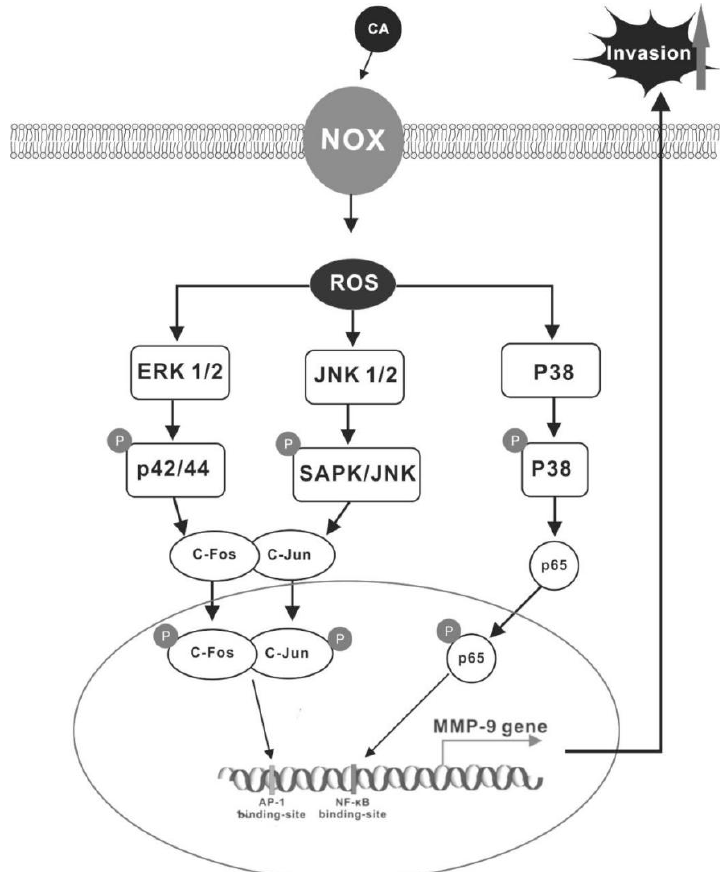
Figure 8. Scheme of the mechanism underlying CA-induced MMP-9 expression in colon cancer cells. CA stimulates NADPH oxidation, which in turn activates ROS-activated MAPK (ERK1/2, JNK, and p38 MAPK). ERK1/2, JNK-activated c-fos/c-jun, and p38-activated p65 then translocate into the nucleus. In the nucleus, phospho-c-fos/c-jun binds to the AP-1 binding site and phospho-p65 binds to the NF- κ B binding site, triggering MMP-9 expression and cell invasion.